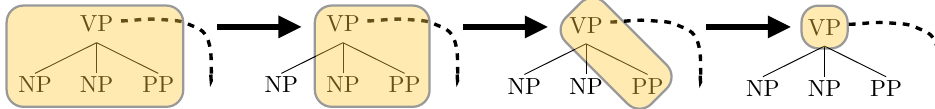
Figure 12: This illustrates the procedure for sampling a modifier at the right edge of a VP . The distribution over modifiers is conditioned on the modifier’s context, which contains its VP parent and left siblings, as illustrated on the left of the figure. This distribution is estimated by successively backing off to smaller